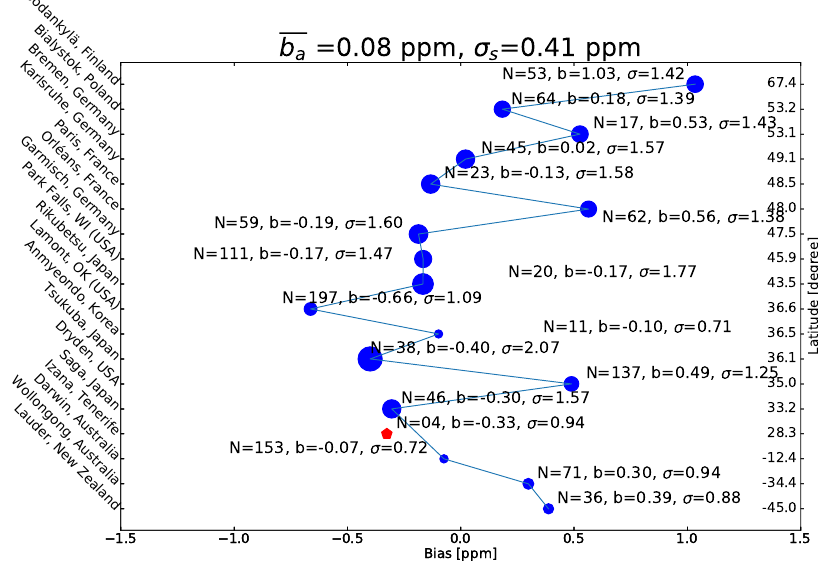
Figure 9. Same as Fig. 8, but for OCO-2 land type measurements obtained under nadir and glint modes. can be captured well by both RemoTeC/OCO-2 retrievals and TCCON measurements. At the Southern Hemisphere, the X CO is more stable throughout the whole time 2